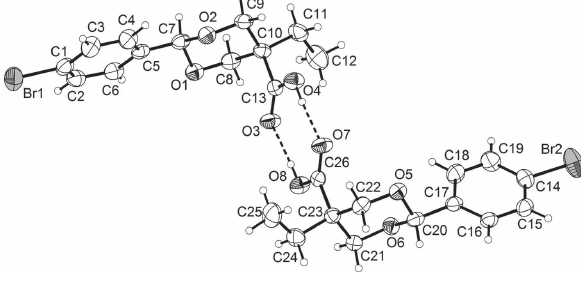
Table 1: Data collection and handling.